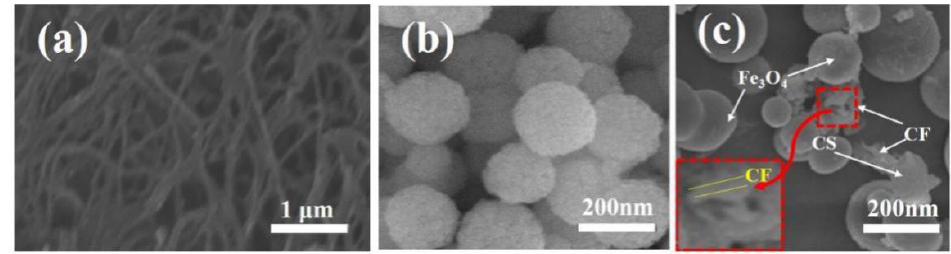
Figure 3. SEM images of CF ( a ), Fe 3 O 4 ( b ) and CFS ( c ).